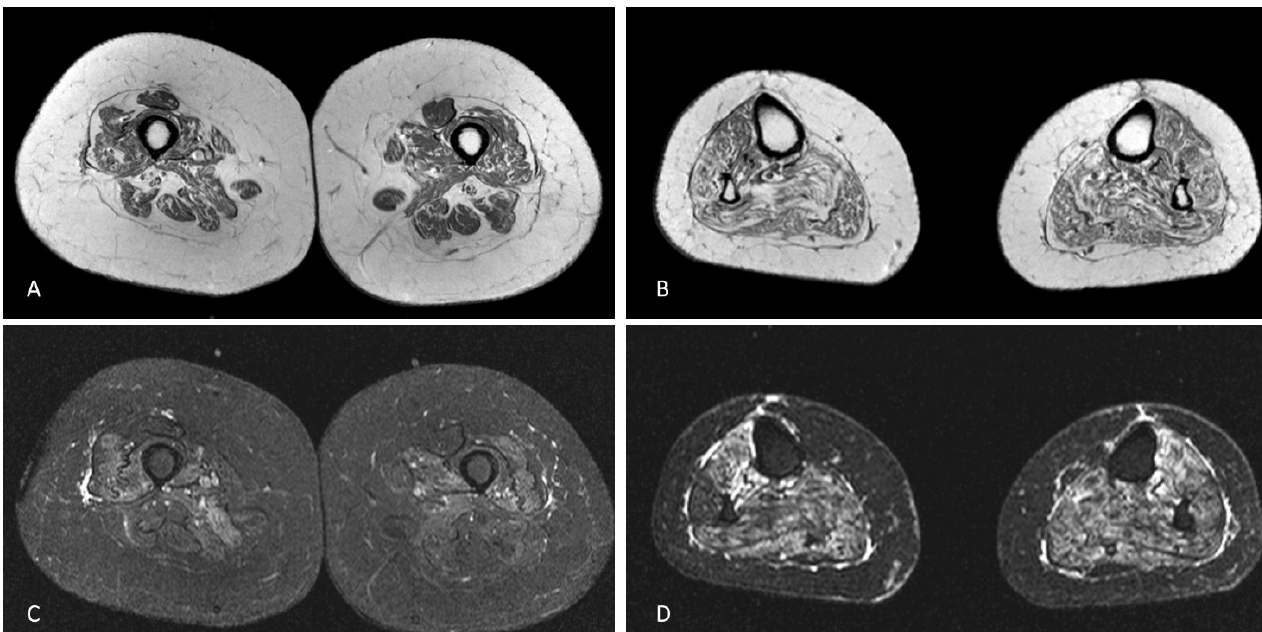
Figure 1. Axial T1-weighted MRI of the mid-thighs ( A ) and middle third of the legs ( B ) demonstrating mild, symmetric muscular fatty atrophy of the quadriceps muscle and the hamstring muscles and moderate fatty atrophy of all leg muscles. Axial STIR-weighted images of the thighs ( C ) and legs ( D ) at the same levels of A and B showing mild oedema of vastus medialis, vastus intermedius, vastus lateralis and, to a lesser degree, of the hamstring muscles in the thighs and severe oedema of all leg muscles.